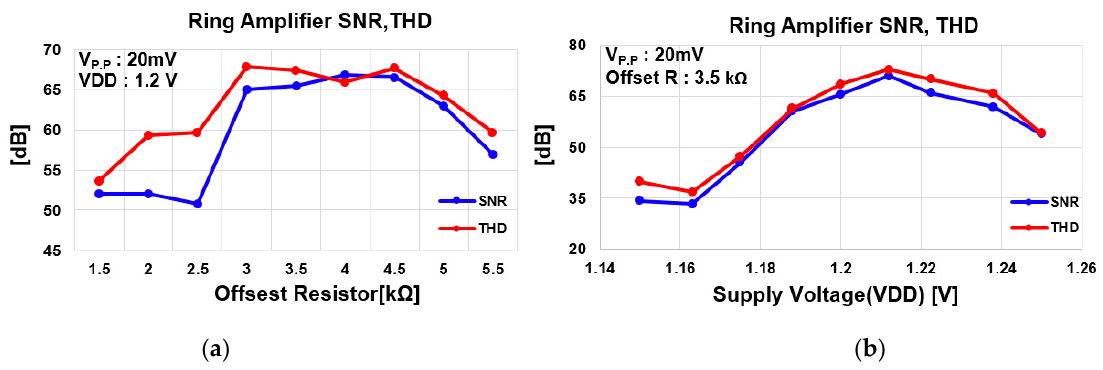
Figure 8. The SNR and THD of ring amplifier versus ( a ) the offset resistor and ( b ) the supply voltage.